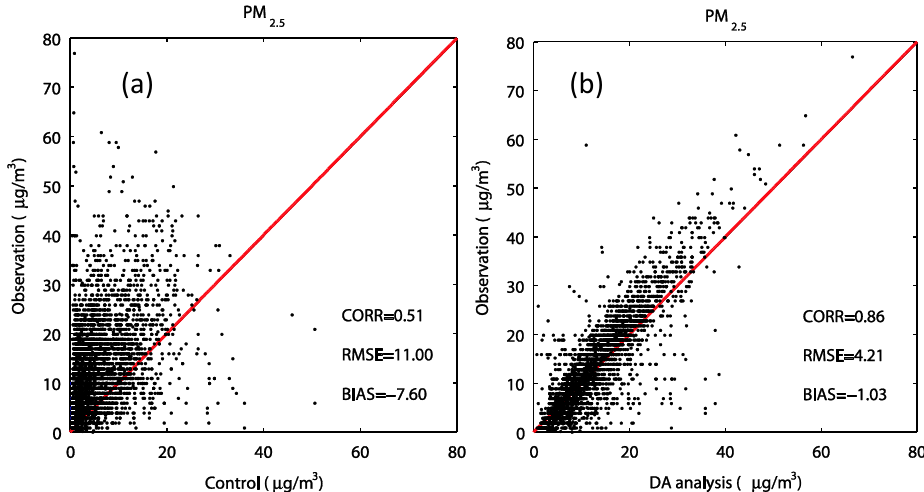
Figure 5. Scatter plots of the PM2.5 mass concentrations against observations in the analysis without (a) and with (b) data assimilation. The observations are assimilated, and consist of the 00:00, 06:00, 12:00 and 18:00UTC observations from the 42 ARB monitoring stations during the period 12:00UTC, 5 May to 12:00UTC, 14 June 2010.